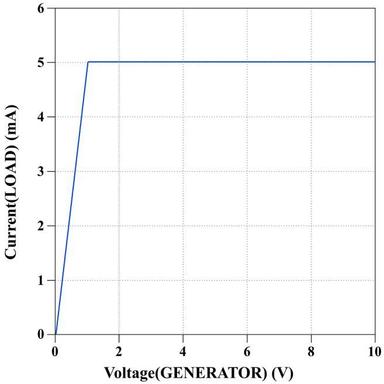
SPICE simulation of the circuit reported in Fig. 1, showing the feasibility of limiting the current that flows over a generic load. The figure is a current vs voltage plot of a 5 mA limited 200 Ω load.